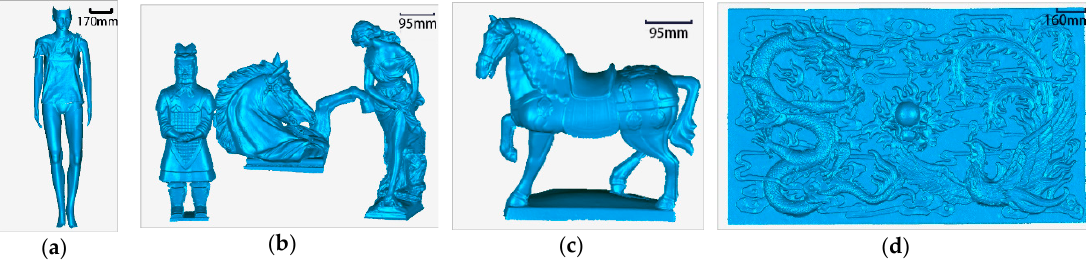
Figure 2. Four experiment objects: ( a ) model, ( b ) small items, ( c ) ceramic horse, and ( d ) emboss.